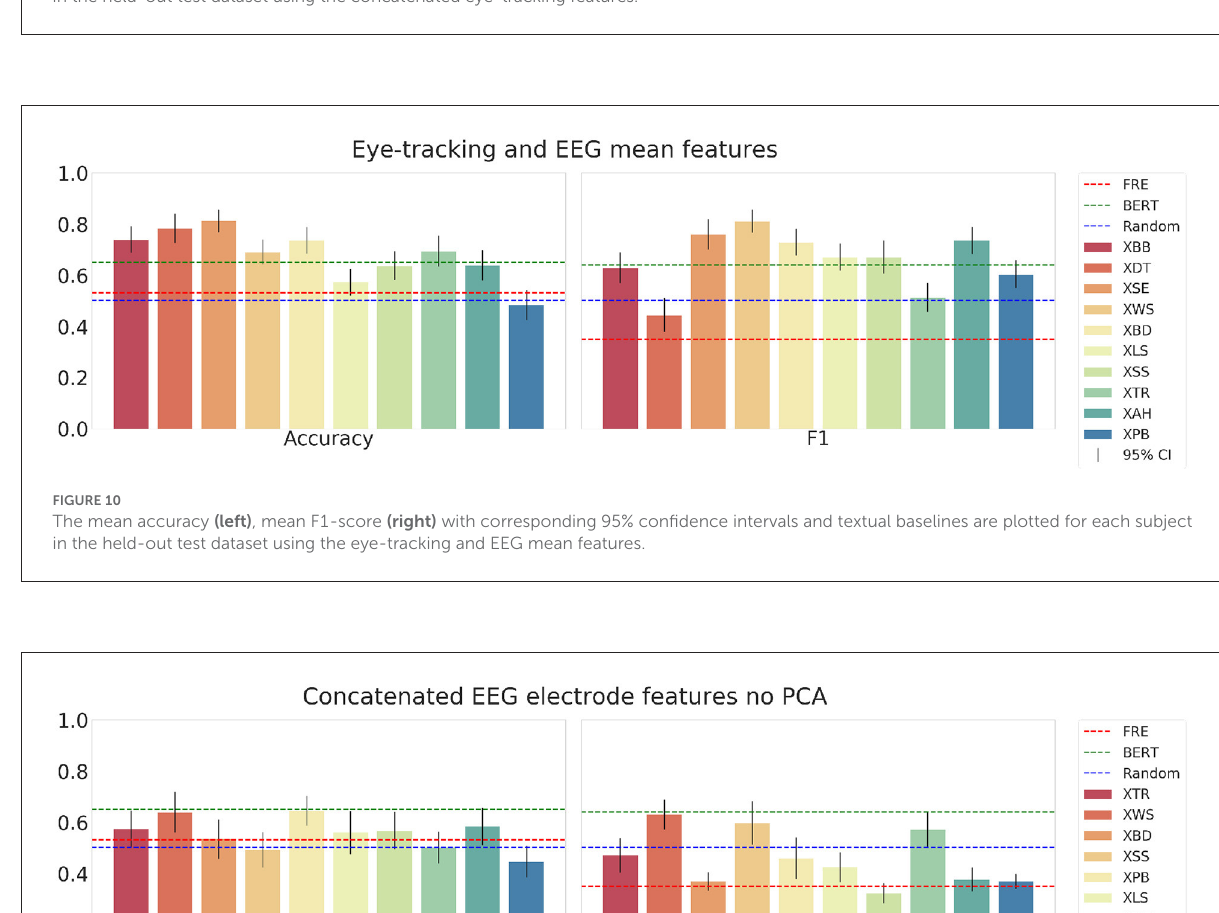
FIGURE9 The mean accuracy (left) , mean F1-score (right) with corresponding 95% confidence intervals and textual baselines are plotted for each subject in the held-out test dataset using the concatenated eye-tracking features.